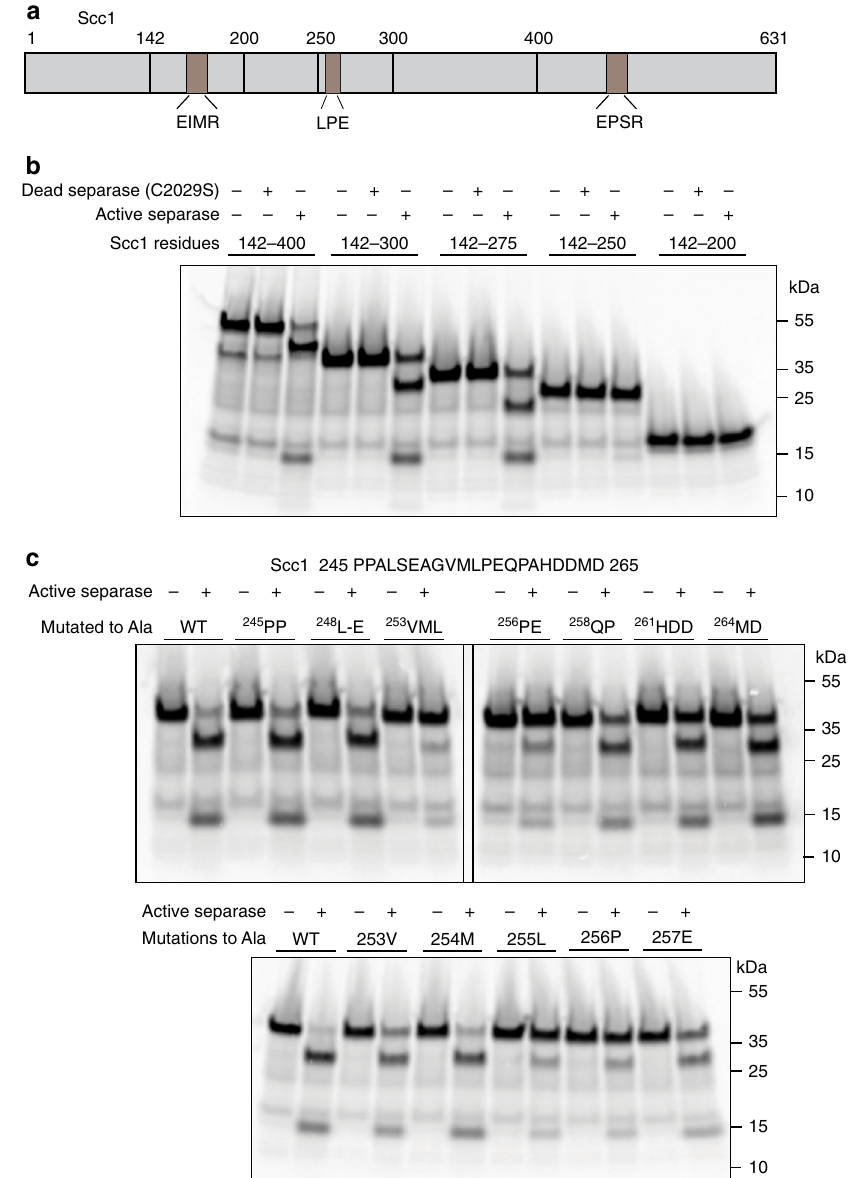
Fig. 2 Identi fi cation of a separase docking motif on Scc1. a Diagram of the Scc1 sequence, showing the locations of two separase cleavage sites, LPE motif, and boundaries of truncated constructs evaluated in panels b and c . b 35 S-labeled Scc1 fragments were incubated with active or inactive separase as indicated, and reaction products were analyzed by SDS-PAGE and Phosphorimaging. c Separase was incubated with an 35 S-labeled Scc1 fragment (aa 142 – 300) in which the indicated residues were changed to alanines. Reaction products were analyzed by SDS – PAGE and Phosphorimaging. The sequence of the relevant region of Scc1 is